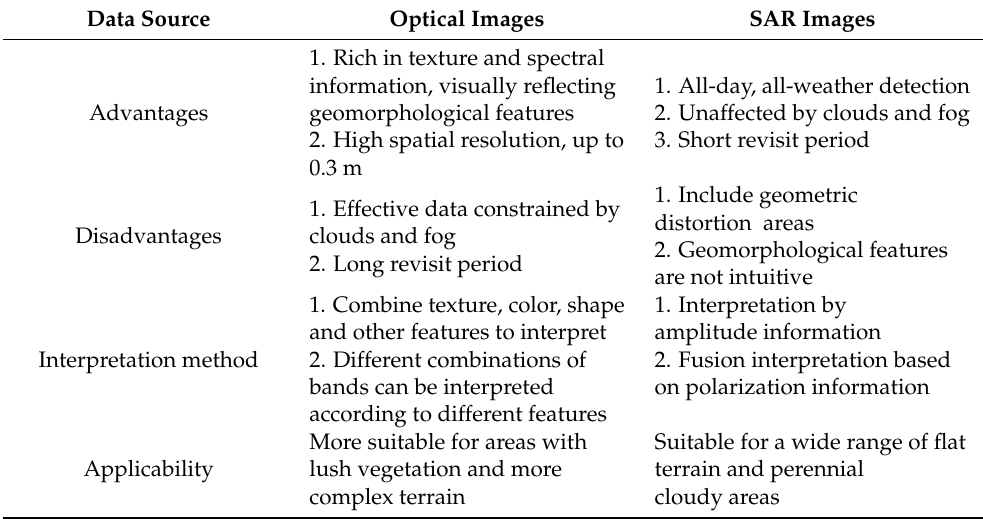
Table 2. Comparison of optical and SAR